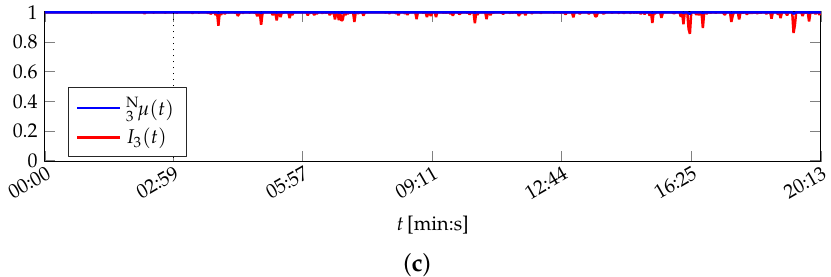
Figure B1. Attribute health evaluation over time during normal operation of the printing unit demonstrator (PU static ). No manipulation or fault occurred during the 20:13(min:s) operation time. Plots ( a – c ) show attribute healths N a µ ( t ) and their corresponding importances I a ( t ) . Variations in the curves are due to effects of the operation itself. Training data was acquired up to 2:59(min:s) (100 plate cylinder revolutions, cf. the black dotted line). Attribute composition according to Table 4. ( a ) Attribute